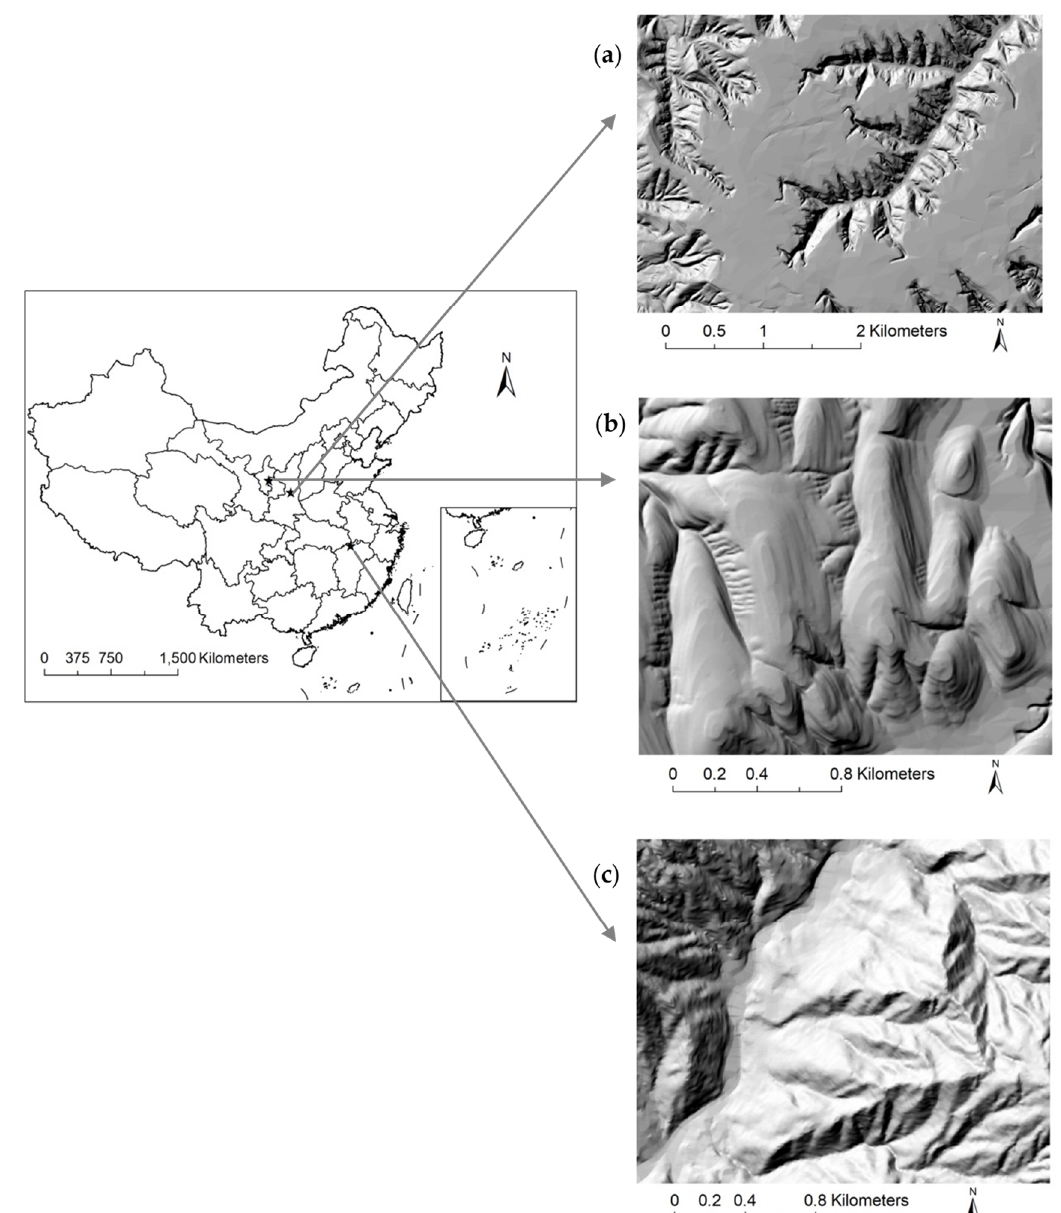
Figure 1. Location and topography of three study areas: hill-shading maps generated from reference DEMs of 5 m for ( a ) study area 1, ( b ) study area 2, ( c ) and study area 3. Contour lines are acquired from digitized data of topographic maps (Figure 2); the contour interval is 10 m and the elevation sampling points are collected from topographic maps. As the elevation sampling points are too sparse, the error of the DEM obtained via interpolation is relatively large; thus, we dispersed the contour lines into points to be combined with elevation sampling points used for DEM construction. A DEM of 5-m resolution produced by the State Bureau of Surveying and Mapping is taken as a reference. The DEM constructed by sampling point interpolation also has a resolution of 5 m. The DEM produced by the State Bureau of Surveying and Mapping is interpolated by a TIN constructed with contour lines of 5-m contour intervals. Owing to the limitations of measurement, there is always a certain degree of error in spatial data [31]. There are no so-called “true values” in data in geosciences and only data of high precision can be taken as reference data which are acceptable and reasonable [32].